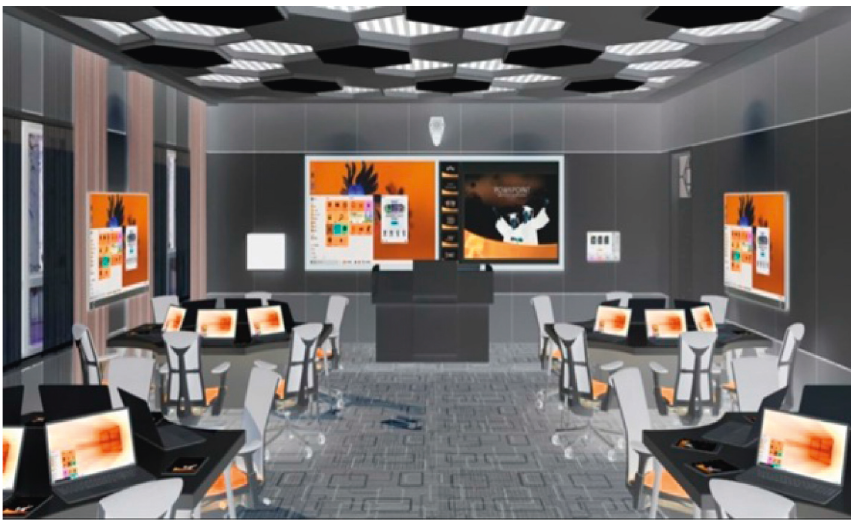
Figure 10: Simulation of ideological and political teaching based on the Internet of Things. Table 1: Simulation evaluation of ideological and political teaching system based on Internet of Things technology. Num Simulation teaching Num Simulation